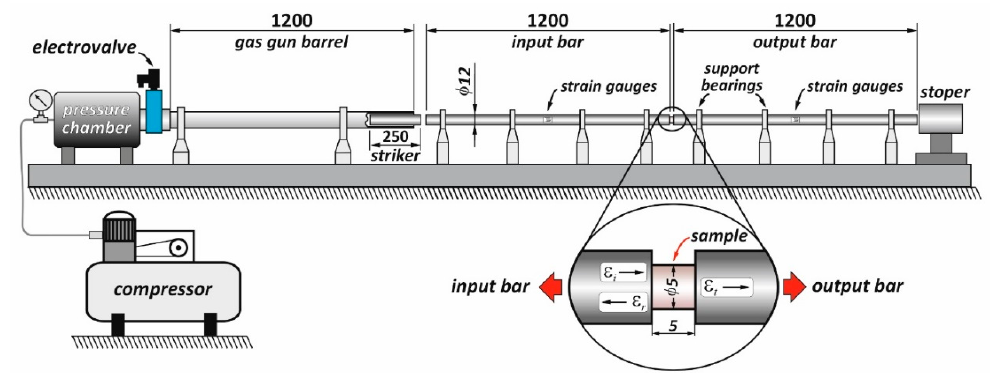
Figure 1. The schematics of the split Hopkinson pressure bar (SHPB) system used in this study [22].